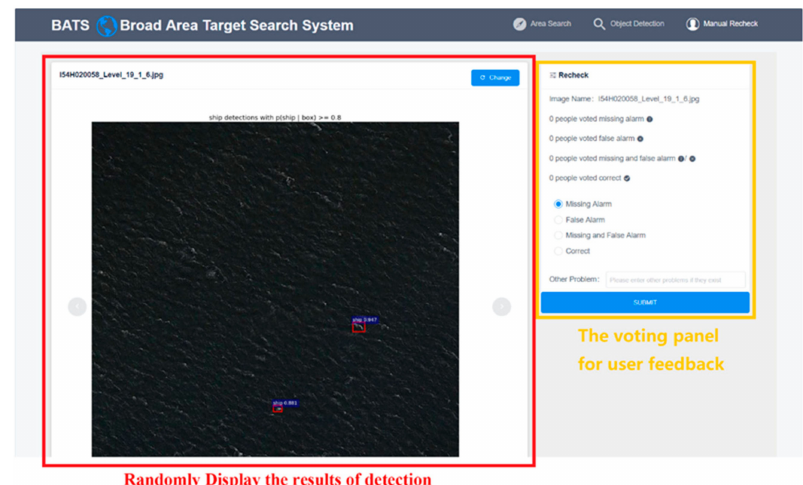
Figure 14. The interface of manual review module.